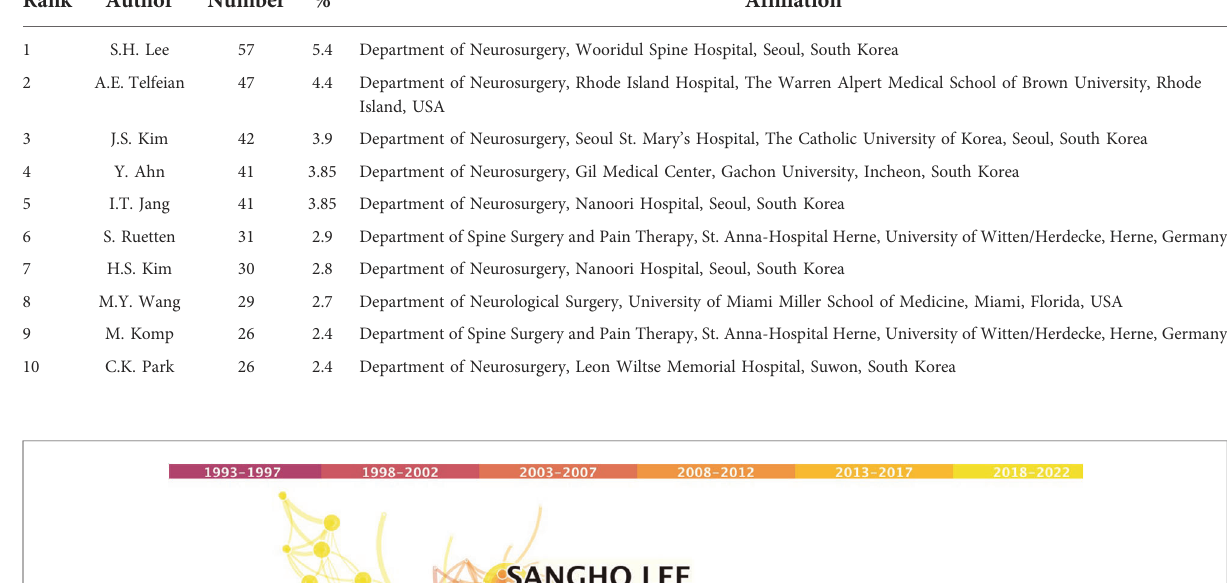
TABLE 4 Top 10 productive authors in the FESS fi eld.